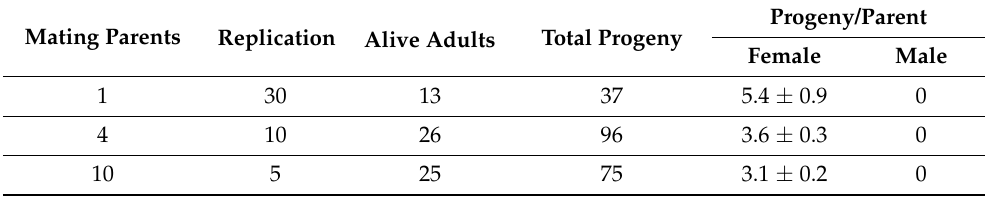
Table 1. Progeny test using different numbers of mating parents.